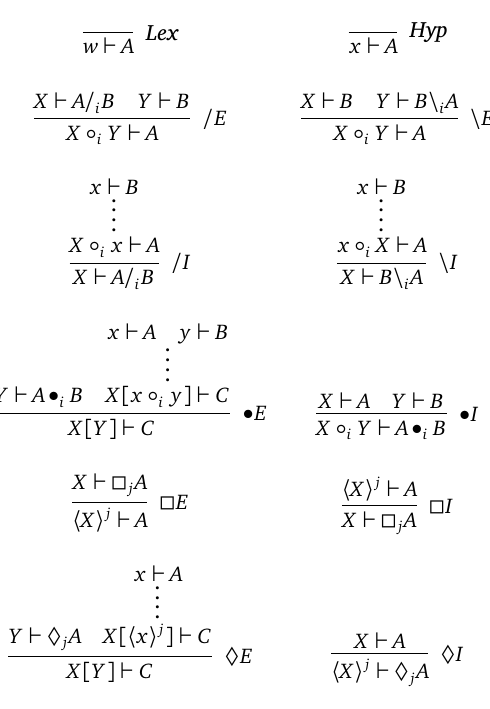
Full set of logical rules for multimodal